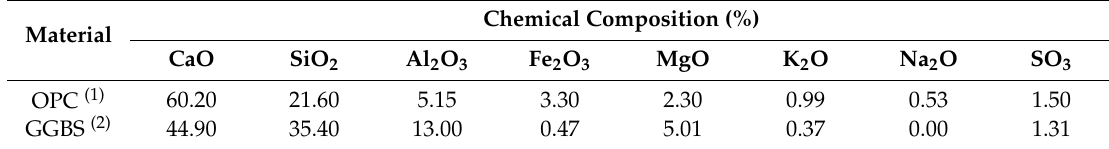
Table 1. Chemical compositions of the used binders.